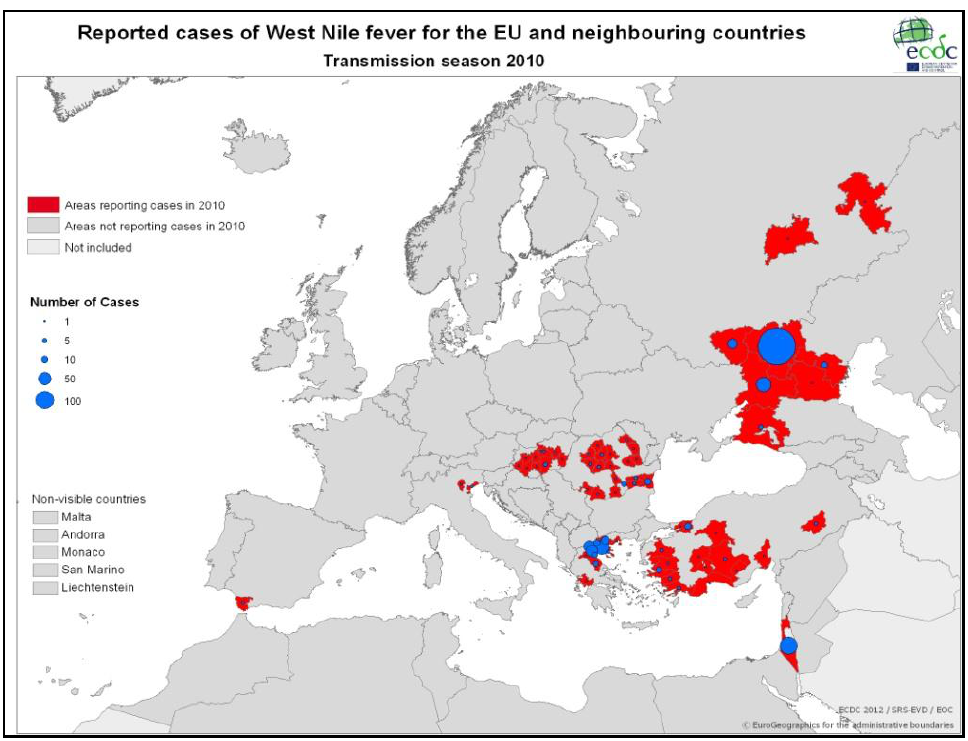
Figure 3. WNV human cases in EU and neighboring countries, 2010 ( Source: http://www.ecdc.europa.eu/).